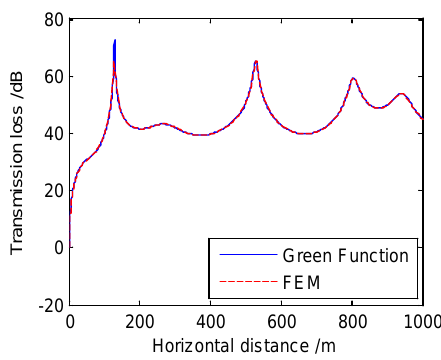
Figure 2. Comparison of far field transmission loss between Green’s function method and finite element method.